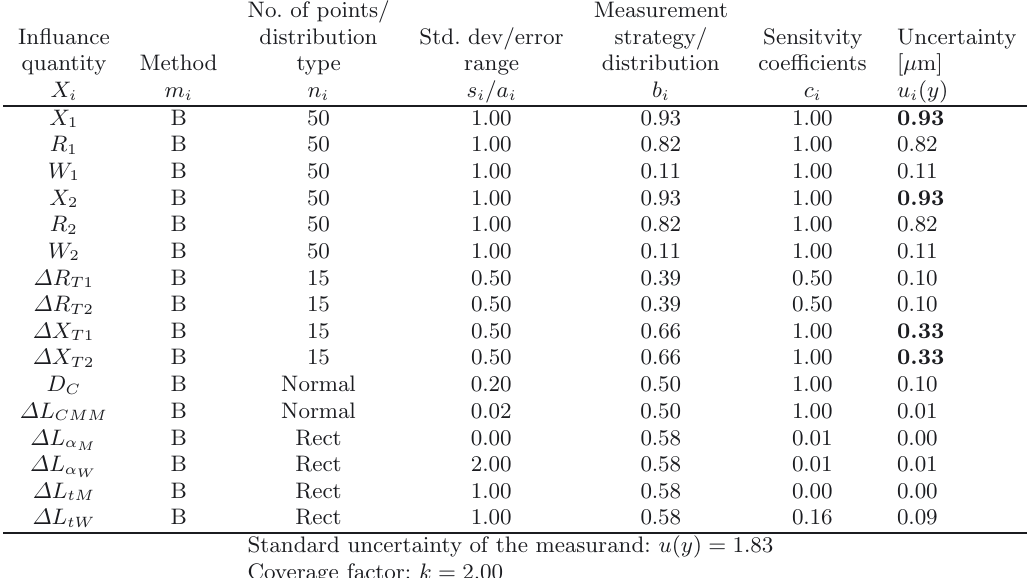
Table 4. Result of the calibration of the inside-radius distance.